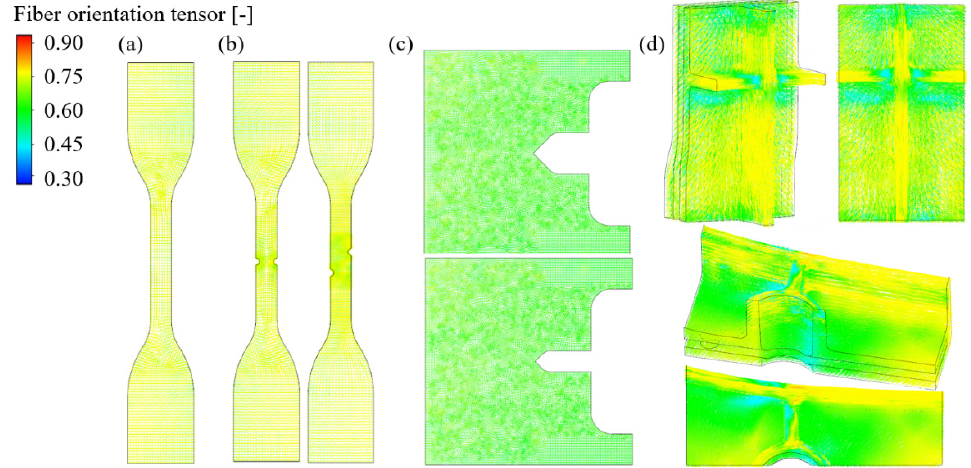
Figure 13. The mapping results of the ( a ) uniaxial, ( b ) notched, ( c ) complex, and ( d ) cross-member specimens.